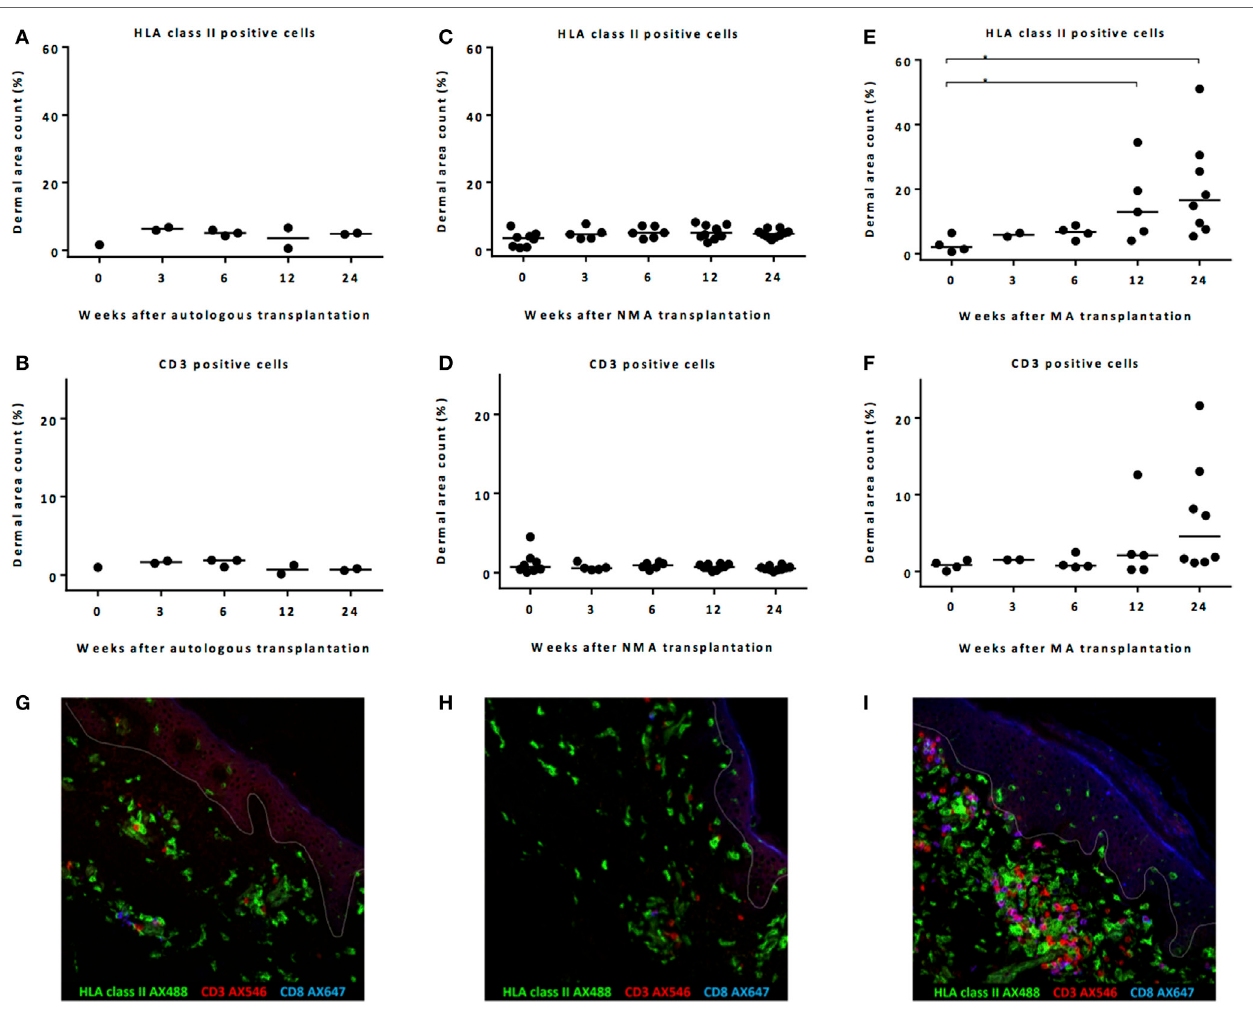
FigUre 2 | Remarkable increase in HLA class II-expressing cells after myeloablative (MA) allogeneic stem cell transplantation (alloSCT). Calculated dermal area counts with medians are depicted. No increase in HLA class II-expressing cells (a) or T-cells (B) was observed after autoSCT. Also, no increase in HLA class II-expressing cells (c) or T-cells (D) was observed after non-myeloablative (NMA) alloSCT. In contrast, following MA, alloSCT there was a significant increase in HLA class II-expressing cells after 12 and 24 weeks compared to T = 0 (Kruskal–Wallis test p = 0.020 and post hoc Mann–Whitney U -test p = 0.03 and 0.008) (e) and a non-significant increase in T-cells after 24 weeks (Kruskal–Wallis test p = 0.12) (F) . (g–i) Results of fluorescence microscopy of illustrative examples showing HLA class II- and CD3-expressing cells 24 weeks after autologous (g) , NMA (h) , or MA (i) transplantation. White line demarks the border between dermis and